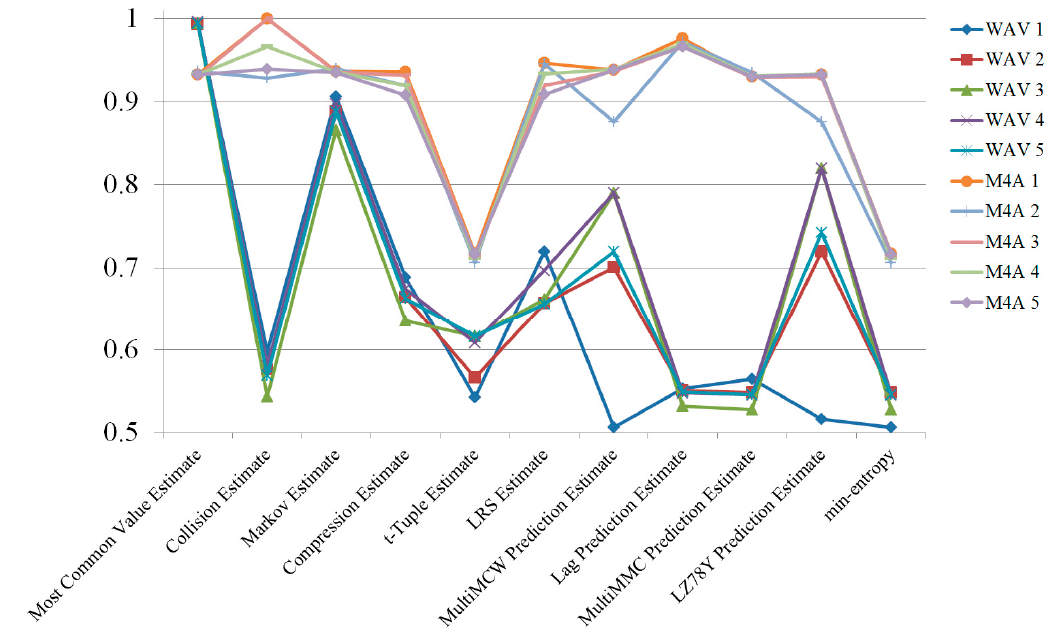
Figure 3. Randomness estimation results of radio signals collected from a single channel. Table 1. Randomness estimation results of 10 radio signals collected from a single